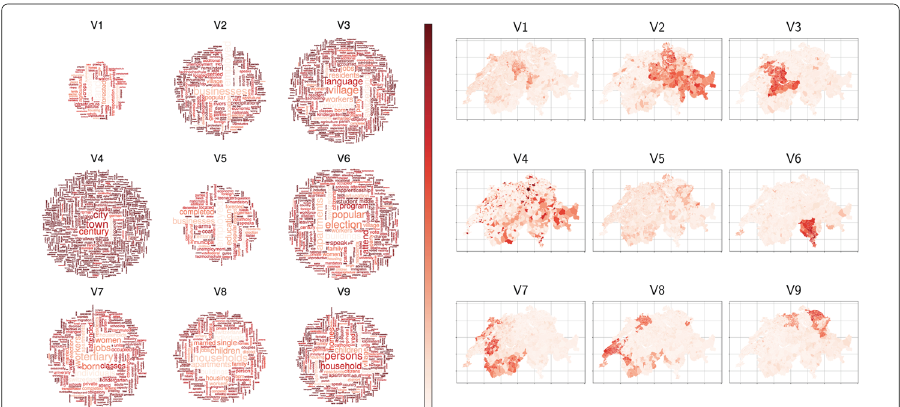
Fig. 3 For k = 9 topics, Left : topic wordclouds (Fellows 2014) obtained from the C matrix for topic model with parameters: burning = 4 (cid:6) 000, 2 (cid:6) 000 iteration, thin = 500, seeds = { 2 (cid:6) 003,5,63,100 (cid:6) 001,756 } , nstart = 5 and best = true. The colour scale is the inverse of the frequency of the word in the whole dataset (e.g. more specific words are darker than common words) whereas their size represents their importance in the topic. Right : related maps with the probabilities of the municipalities over each topic (Map base source: